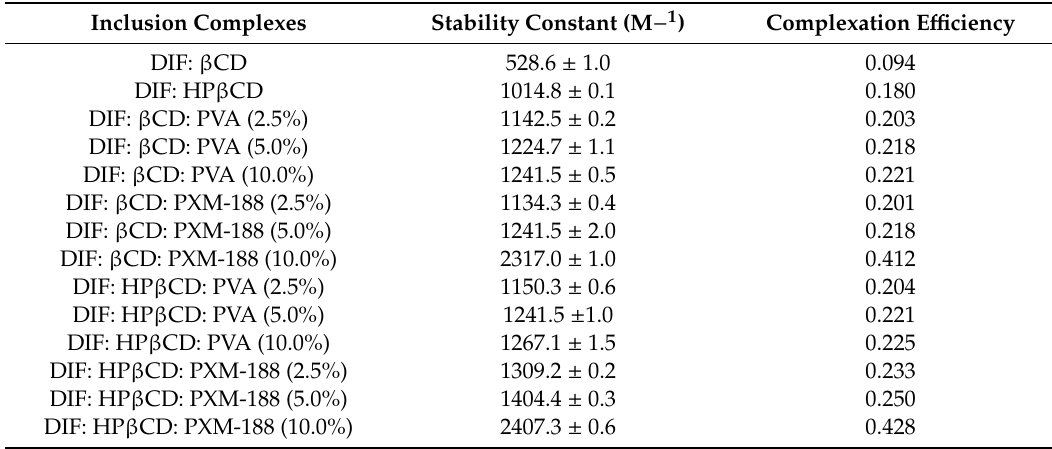
Table1. Stabilityconstantandcomplexatione ffi ciencyresultsofbinaryandternaryinclusioncomplexes.